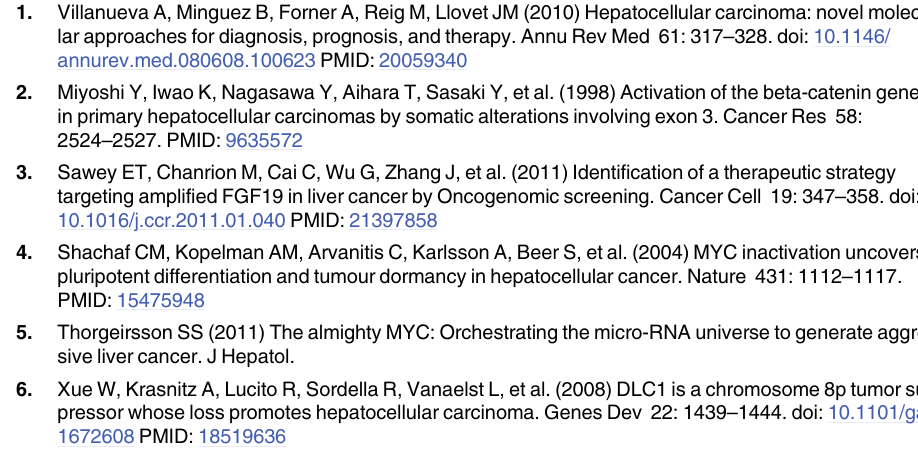
S4 Fig. Classification of human HCC based on expression of RXR- α and Wnt pathway genes. HCC and non-malignant liver samples in the Wurmbach et al. dataset[25] were clus- tered based on expression of 138 RXR- α and Wnt pathway genes. Beneath the heatmap are three rows, showing for each sample (1) the one of two major clusters it belonged to following unsupervised clustering based on all genes; (2) relative prognosis based on the 65-gene signa- ture of Kim et al., red = poor, green = good, white = neutral; (3) CTNNB1 -mutation signature status, red = expression, green = less expression of the 5-gene signature associated with CTNNB1 mutation[12]. S5 Fig. Classification of human HCC based on expression of RXR- α and Wnt pathway genes. HCC samples in the Kim et al. dataset[24] were clustered based on expression of 138 RXR- α and Wnt pathway genes. Beneath the heatmap are three rows, showing for each HCC sample (1) the one of two major clusters it belonged to following unsupervised clustering based on all genes; (2) relative prognosis based on the 65-gene signature of Kim et al.[24], red = poor, green = good, white = neutral; (3) CTNNB1 -mutation signature status, red = expression, green = less expression of the 5-gene signature associated with CTNNB1 mutation[12]. S1 Table. Focal amplicons observed in transpantable hepatoblast-derived tumors. S2 Table. List of genes in the RXR- α and Wnt- pathways S3 Table. List of mouse tumors and normal liver samples used for gene expression